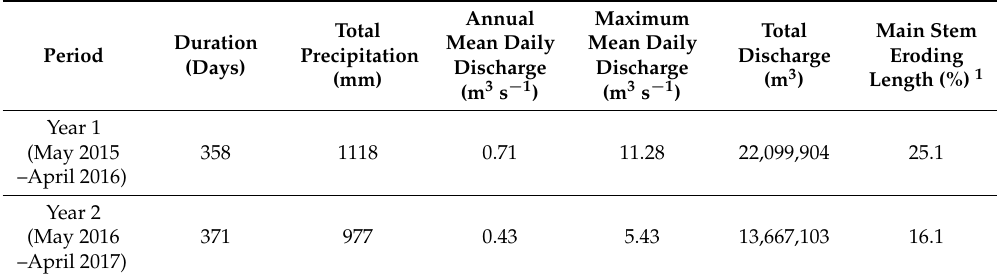
Table 2. Precipitation, hydrology, and eroding streambank length data for Walnut Creek, Iowa, for 2 represents March, 2017 streambank eroding length assessment data.